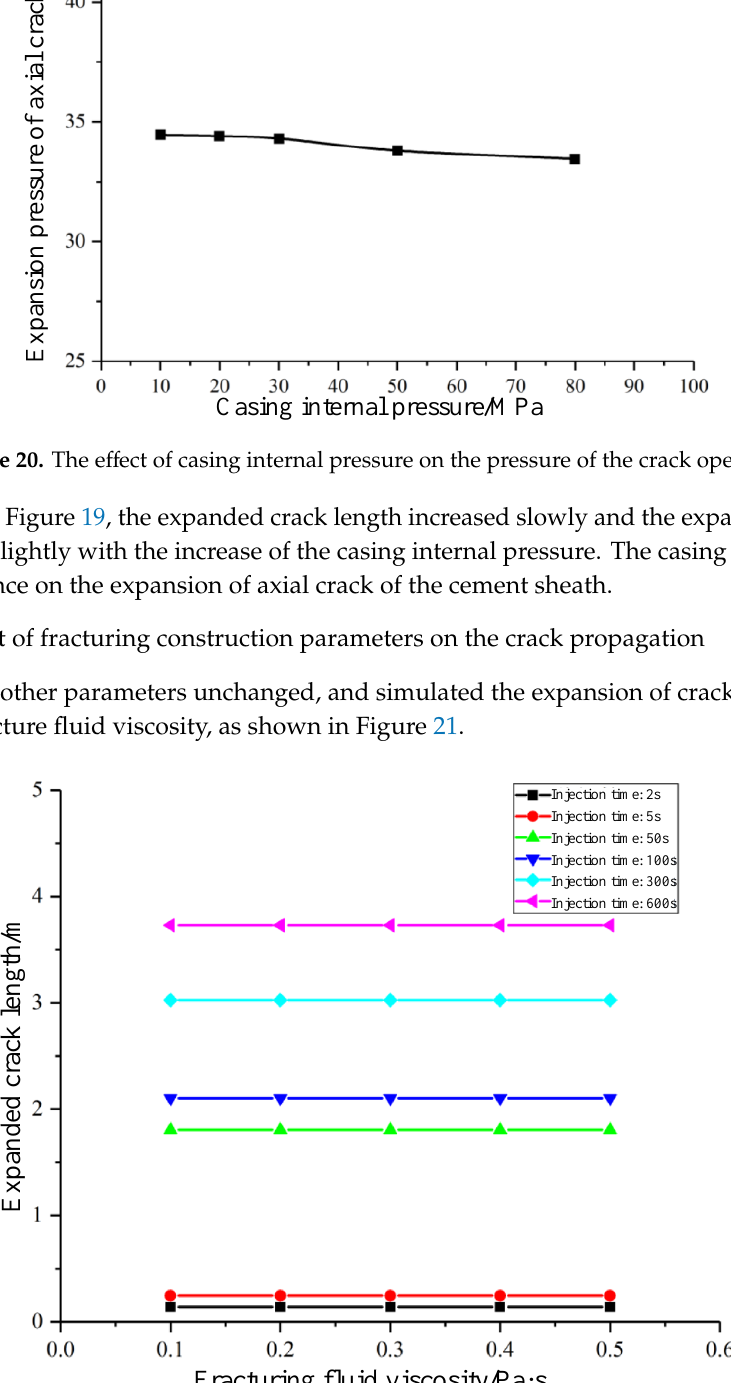
Figure 19. The effect of casing internal pressure on the crack propagation.